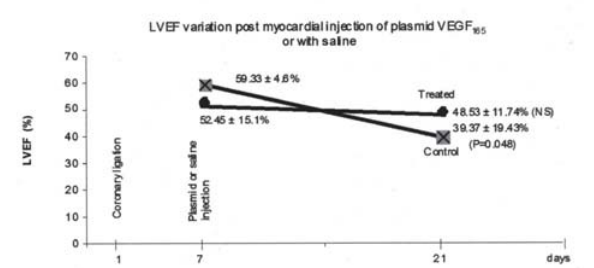
Fig. 2 - Mean LVEF of control (injected with saline) and treated (injected with plasmid VEGF ) dogs on day 7 (pre-treatment) 165 and day 21 (14 days after treatment). The LVEF declined significantly in the control group and was maintained in the treated group. LVEF= left ventricular ejection fraction